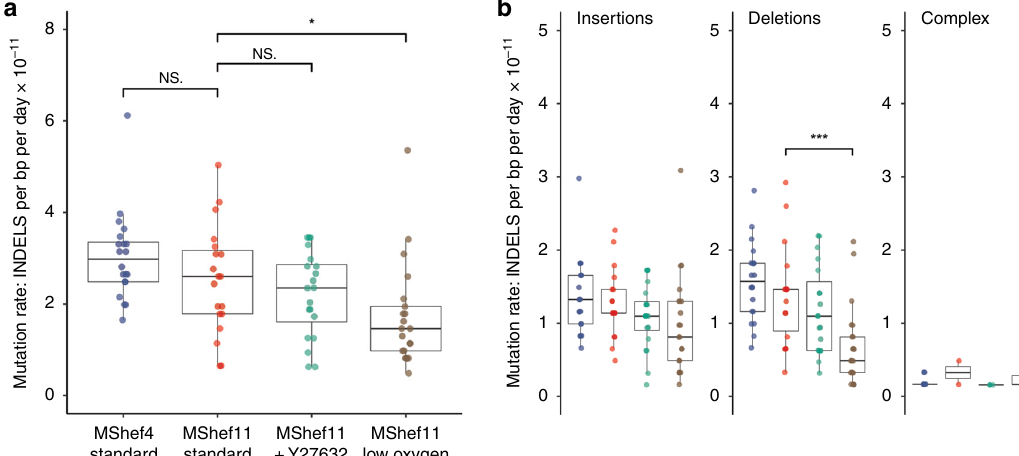
Fig. 4 Mutation rate and genomic distribution of insertion and deletion mutations in different growth-conditions. a Box and whisker plots showing haploid mutation rates all INDELs in subclones derived from clones grown in different conditions. MShef11 subclones derived from low oxygen ( N = 21) showed a signi fi cantly reduced INDEL mutation rate compared to subclones from standard conditions ( N = 19) (assessed by unpaired two-tailed t -test with Welch ’ s correction; P = < 0.02). Taken together, the mutation rates of INDELs were approximately 10-fold lower than the mutation rates of single- nucleotide variants. Boxes represent the 25th – 75th percentiles of the data; whiskers show the min and max range of the data; horizontal lines indicate the median value. ns: P > 0.05; * P ≤ 0.05; ** P ≤ 0.01, *** P ≤ 0.001; **** P ≤ 0.0001. b Box and whisker plots showing haploid mutation rates of insertion, deletion and complex (mixed insertion and deletion) mutations in cells grown in different conditions. MShef11 subclones derived from low oxygen ( N = 21) showed a signi fi cantly reduced number of deletions compared to those from standard conditions ( N = 19) (assessed by unpaired two-tailed t -tests with Welch ’ s correction; P = < 0.0008). The mutation rates of complex INDELs (mixed insertion and deletion) were 10-20X lower than the rates of insertions or deletions across all cell lines and growth conditions. Boxes represent the 25th – 75th percentiles of the data; whiskers show the min and max range of the data; horizontal lines indicate the median value. ns: P > 0.05; * P ≤ 0.05; ** P ≤ 0.01, *** P ≤ 0.001; **** P ≤ 0.0001. Source data are provided in Supplementary Data